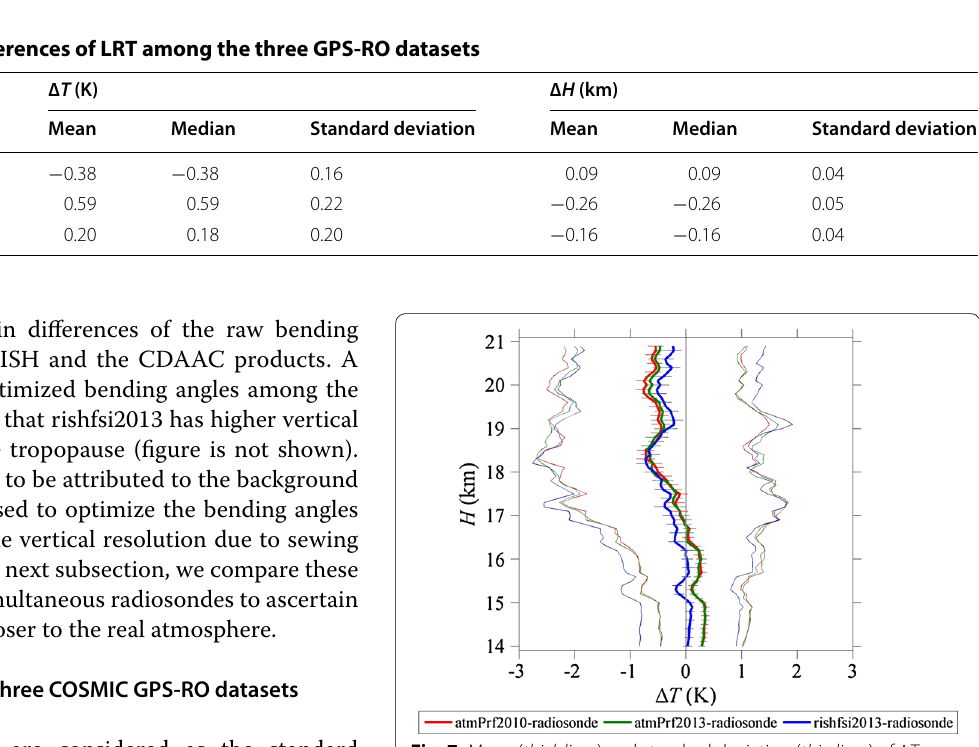
Fig. 7 Mean ( thick lines ) and standard deviation ( thin lines ) of ∆ T between the COSMIC GPS-RO datasets and the radiosonde from the 134 collocated profiles. Horizontal lines at 0.2-km intervals show the standard error of the mean of atmPrf2010-radiosonde ( red ), atmPrf2013-radiosonde ( green ) and rishfsi2013-radiosonde ( blue